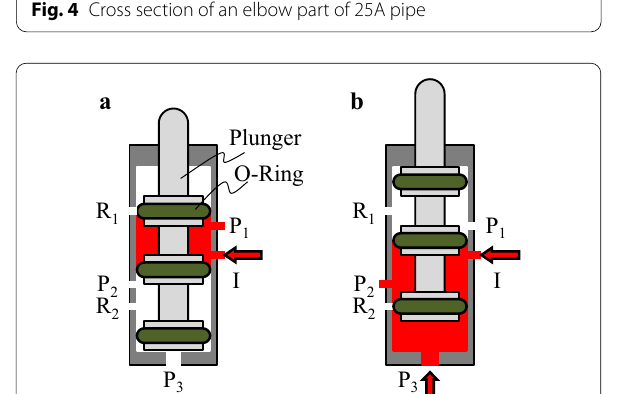
Fig. 2 Overview of the developed device